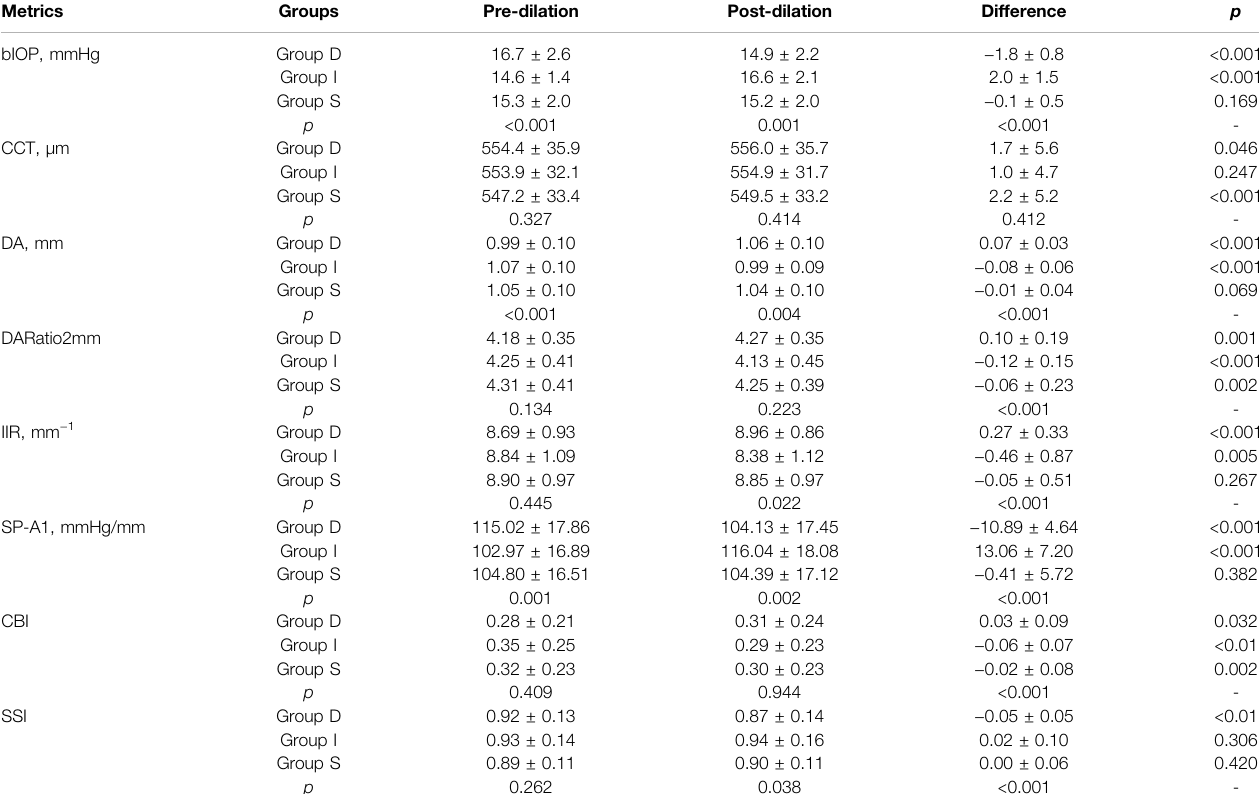
TABLE 2 | CVS metrics collected before and after the mydriasis test in three groups. Metrics